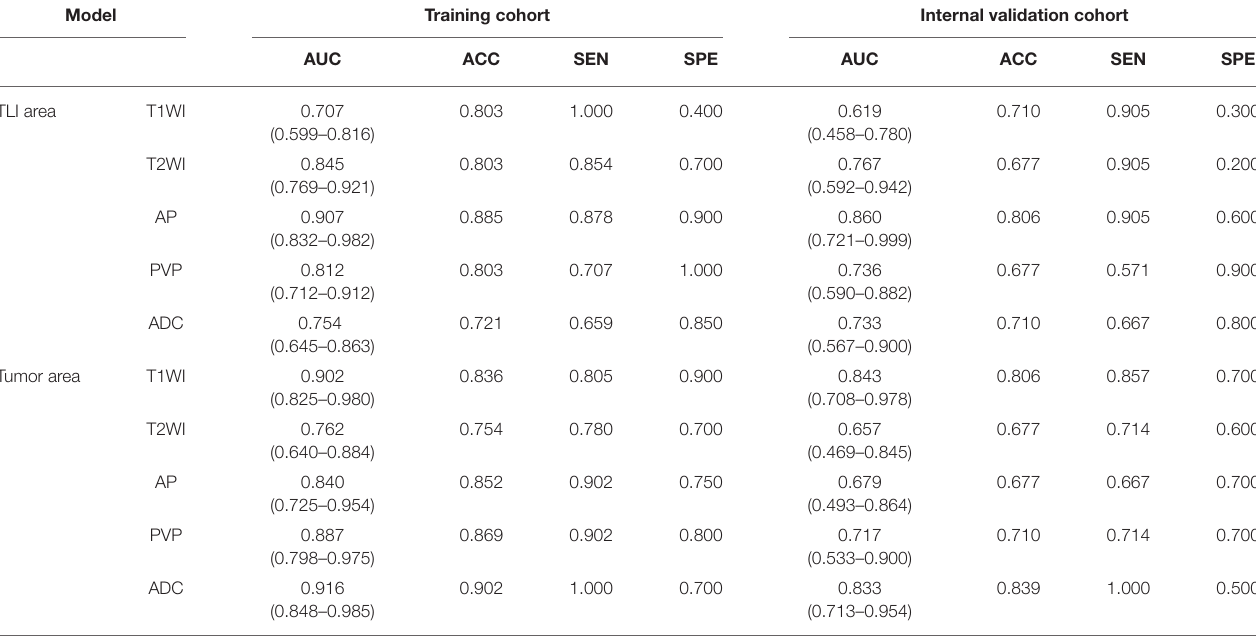
TABLE 4 | Performance of each single sequence in distinguishing HGPs of